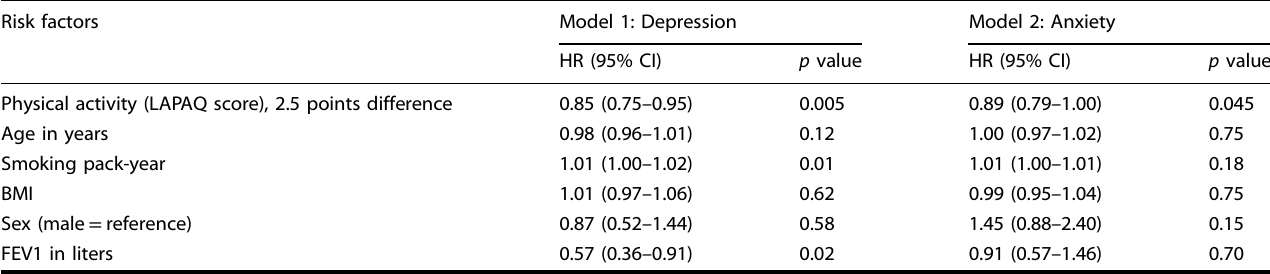
Table 3. Physical activity and risk of depression and anxiety in competing risk model (multinomial logistic